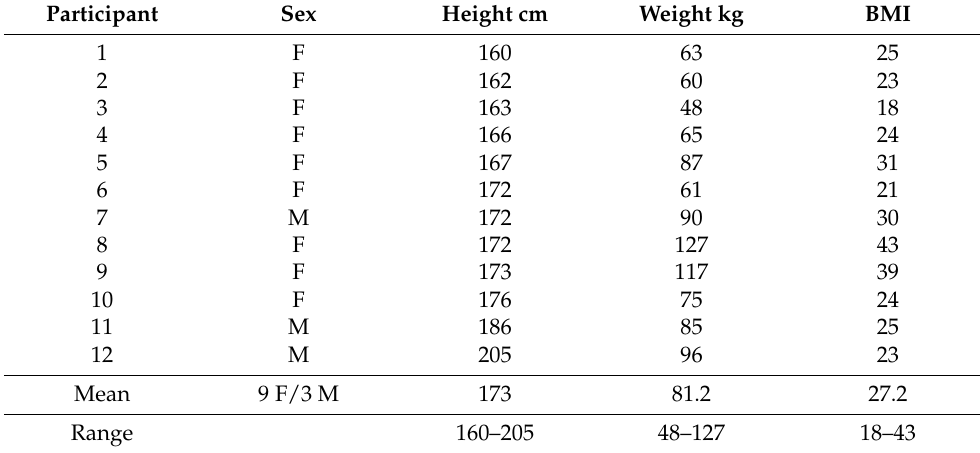
Table 1. Study participants’ sex, height, and weight